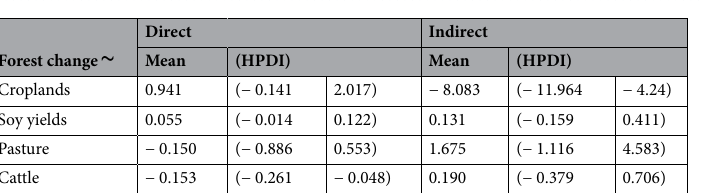
Table 1. Regression of deforestation on agricultural drivers and control variables. We report the posterior mean and boundaries of credible intervals (the highest posterior density intervals (HPDI)) covering 95% of the posterior. Effects are divided into direct effects (within a municipality) and indirect effects (affecting other municipalities). Deforestation is measured as change of forest in hectare per total area in km 2 , croplands and pasture in percent of area, cattle as logged cattle density per pasture, and soy yields in Brazilian Real per harvested area. More information on the model, data, and extended results are provided in the methods section and supplementary